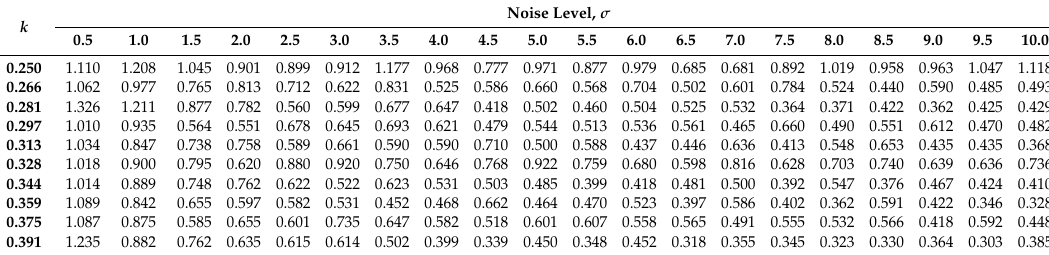
Table A2. For the block size of 64 × 64, MSE levels across a range of noise levels and normalized singular value tail length k